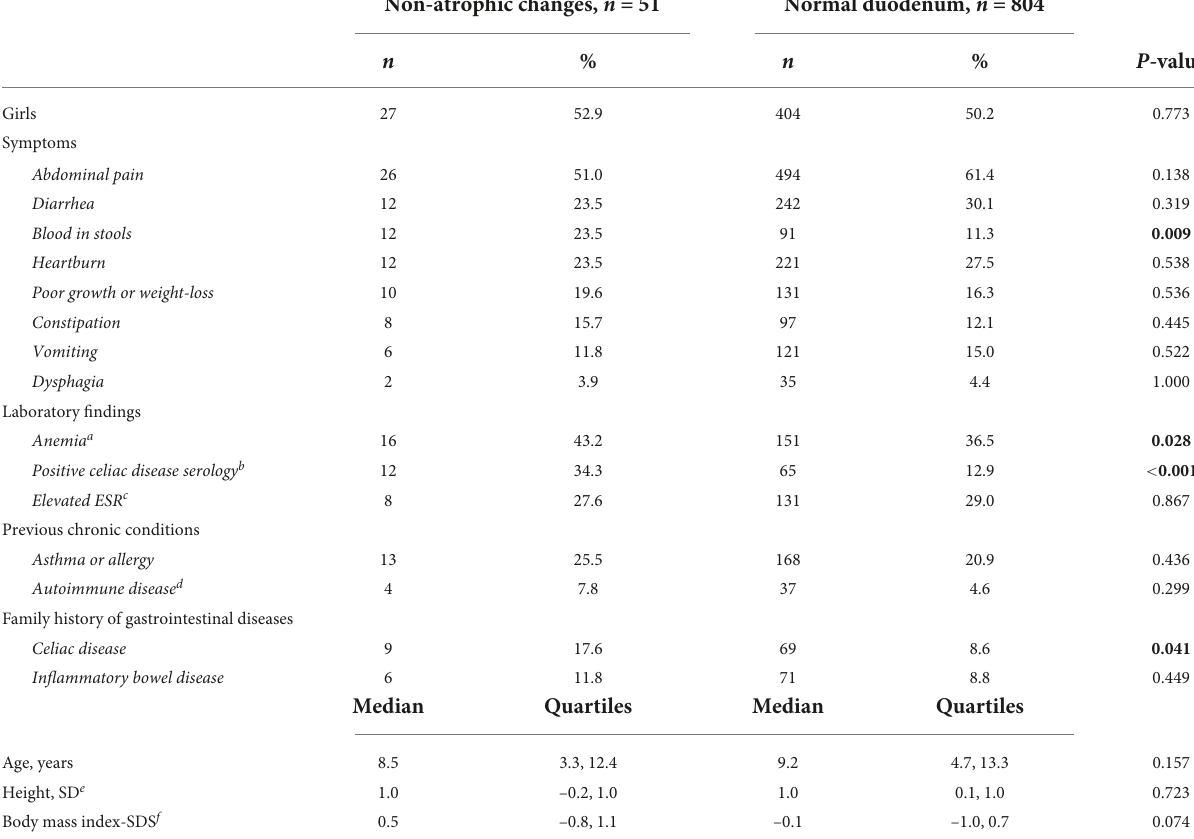
TABLE 1 Comparison of clinical characteristics at the time of first esophagogastroduodenoscopy between children with non-atrophic duodenal changes and those with histologically normal duodenum. Non-atrophic changes, n =